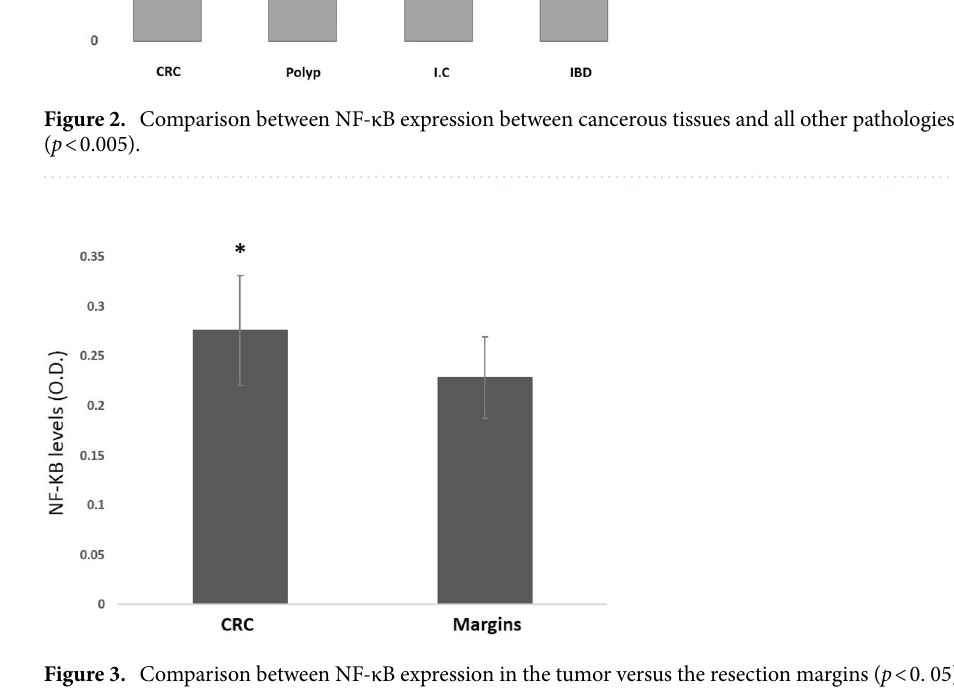
Figure 3. Comparison between NF-κB expression in the tumor versus the resection margins ( p < 0.